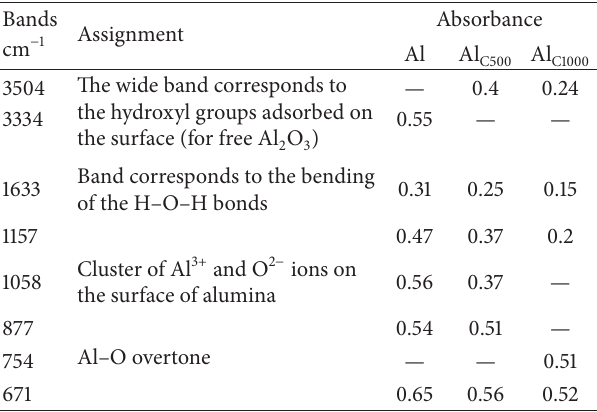
Table 3: DRIFT bands that are characterizing alkali metal treated alumina samples.